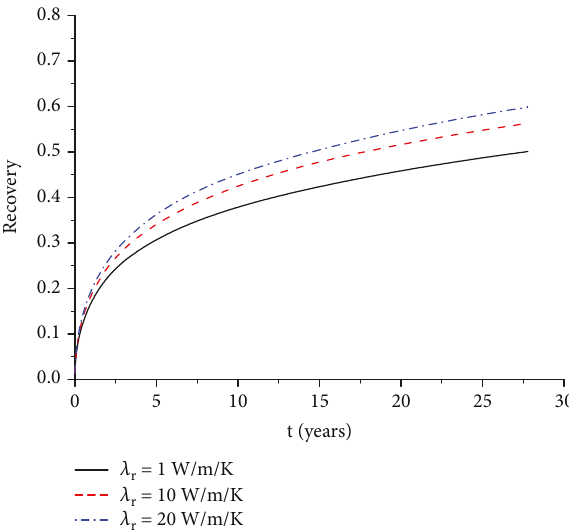
Figure 11: E ff ect of volumetric heat transfer coe ffi cient on shale gas recovery.